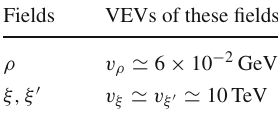
Fields VEVs of these